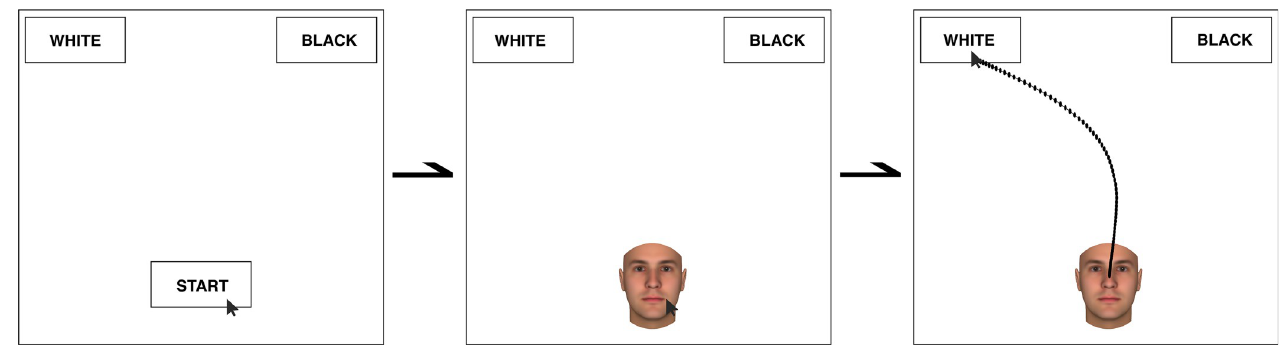
Fig 1. Representative illustration of a typical trial of MT-race-IAT. After clicking on ‘Start’ button at the bottom centre of the screen, the stimulus is presented in its position. The task consists in categorising the stimulus as fast as possible by moving and clicking over the chosen on the top-left or top-right target response alternatives with the computer mouse while the real-time mouse trajectory is